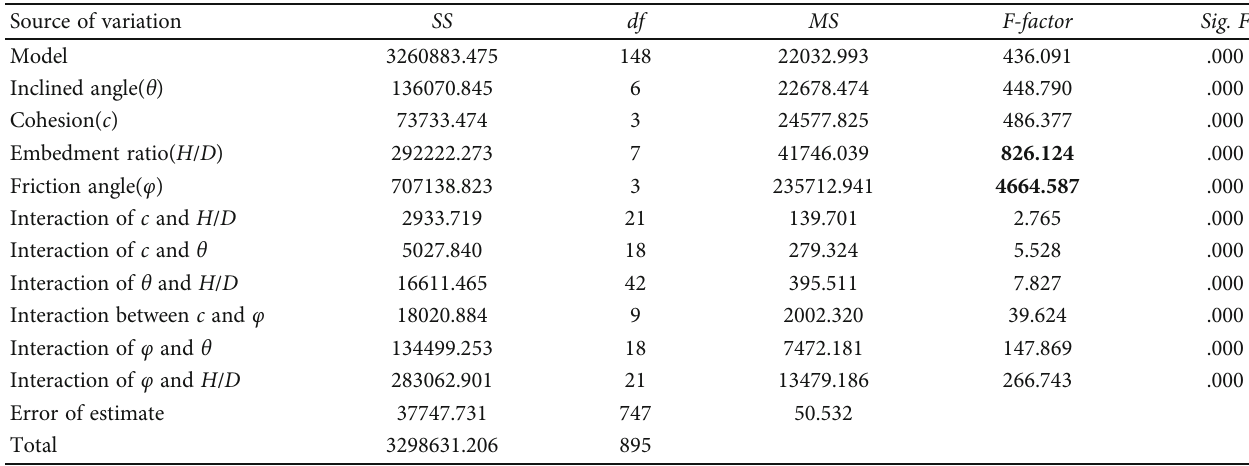
Figure 7: The F -factor of each factor ’ s (a) main e ff ect and (b) interaction e ff ect. Table 2: ANOVA table of N for cohesion, friction angle, inclined angle and embedment ratio(R 2 s